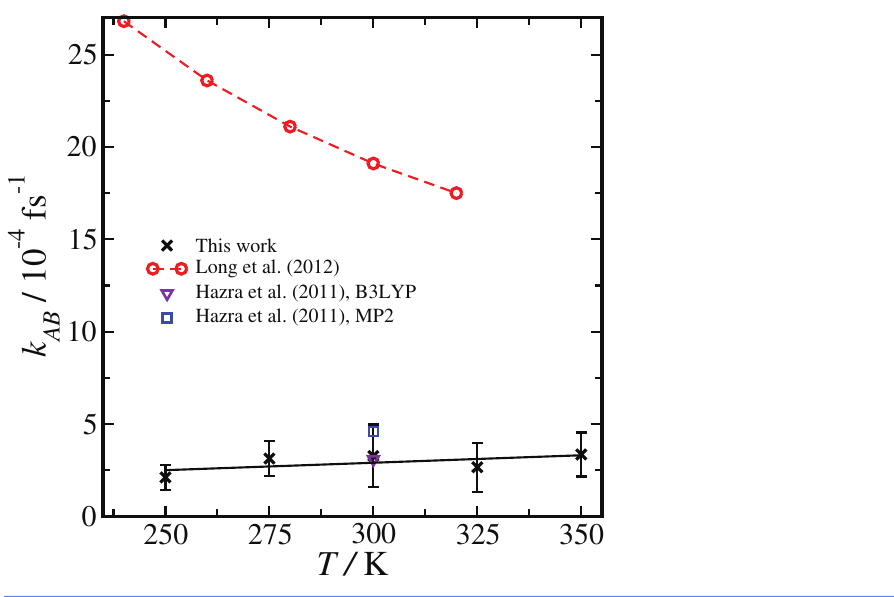
Figure 4 Temperature dependence of the reaction rate coef fi cient k AB , comparing our results with RETIS and the PBE functional and the TZV2P basis set with previous literature results using TST and RRKM theories. Error bars are one standard deviation in the mean. The black line is from a lin- ear regression of the RETIS